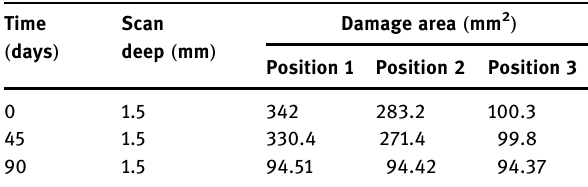
Table 5: Internal damage area of the specimens under impact Table 4: Load growth